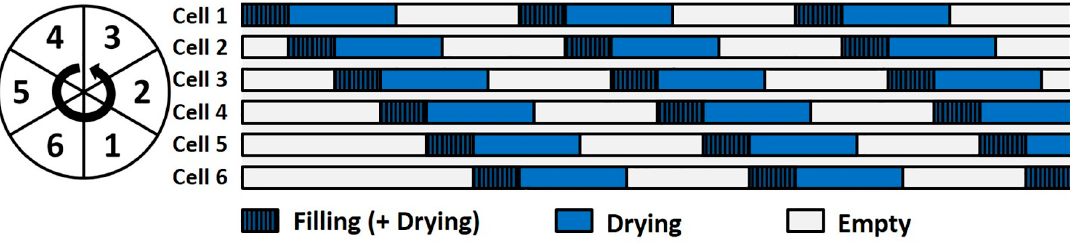
Figure 2. Schematic overview of the different phases during drying in the six-segmented fluid bed dryer of a ConsiGma-25 line. Reproduced with permission from ([29]), Elsevier, 2018.